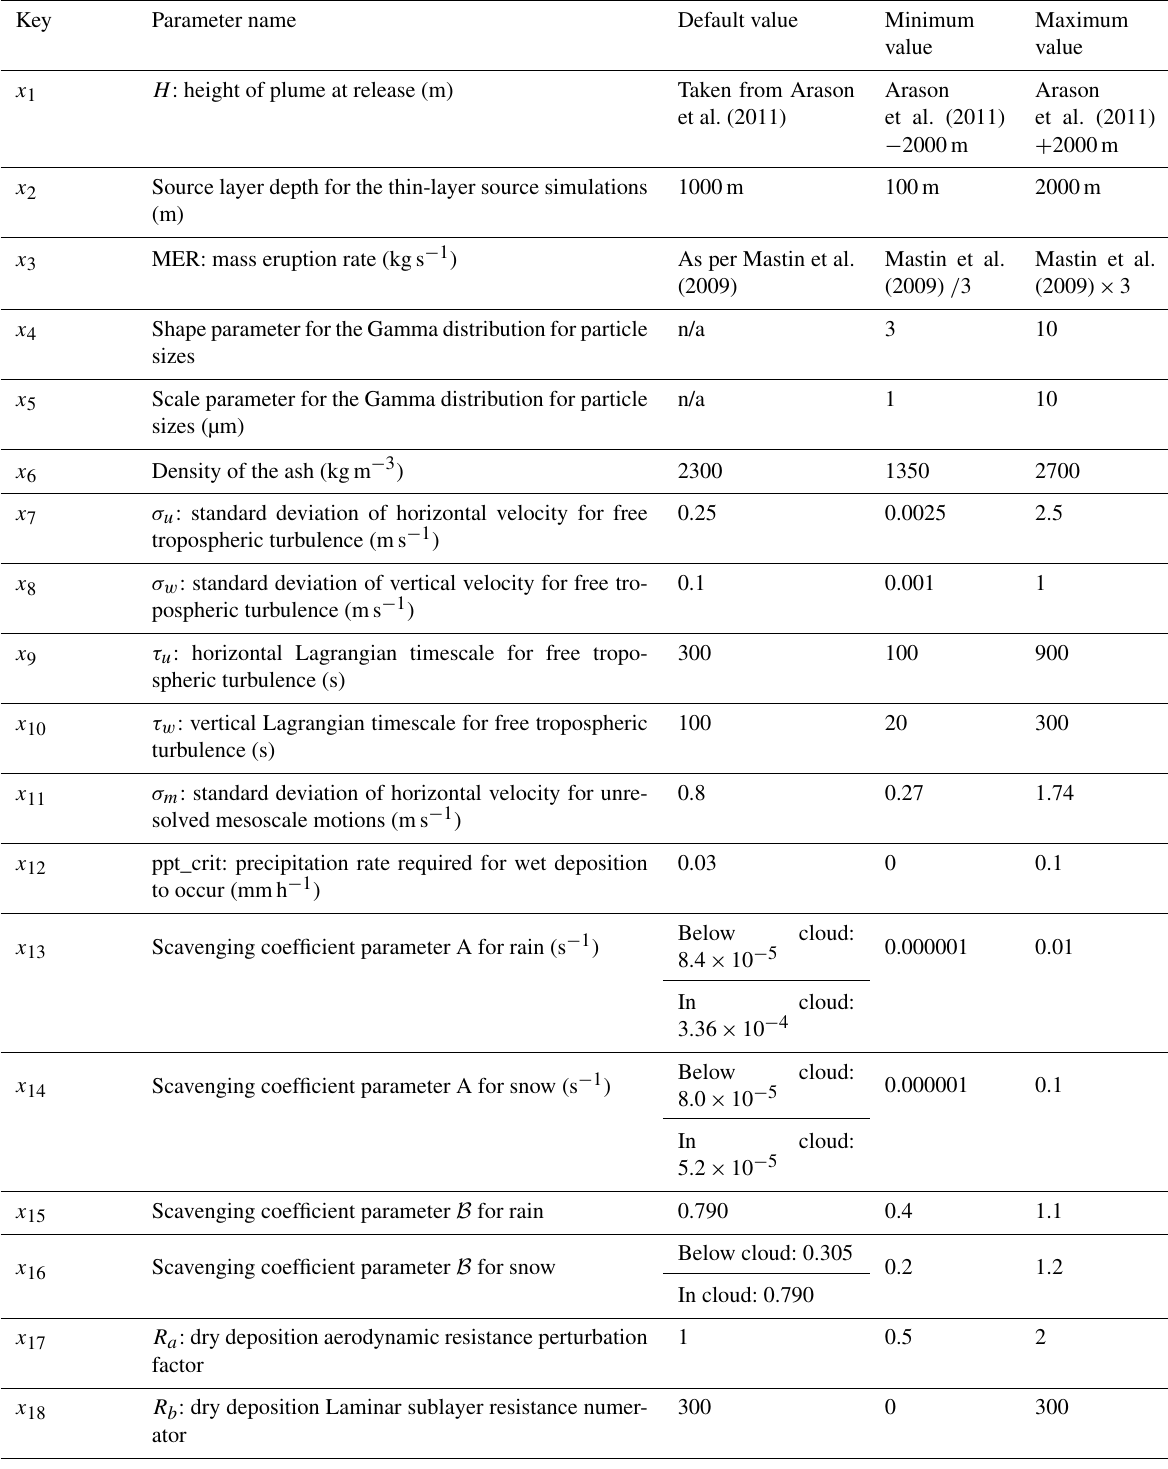
Table 1. Summary of the parameters, default values and ranges used in this